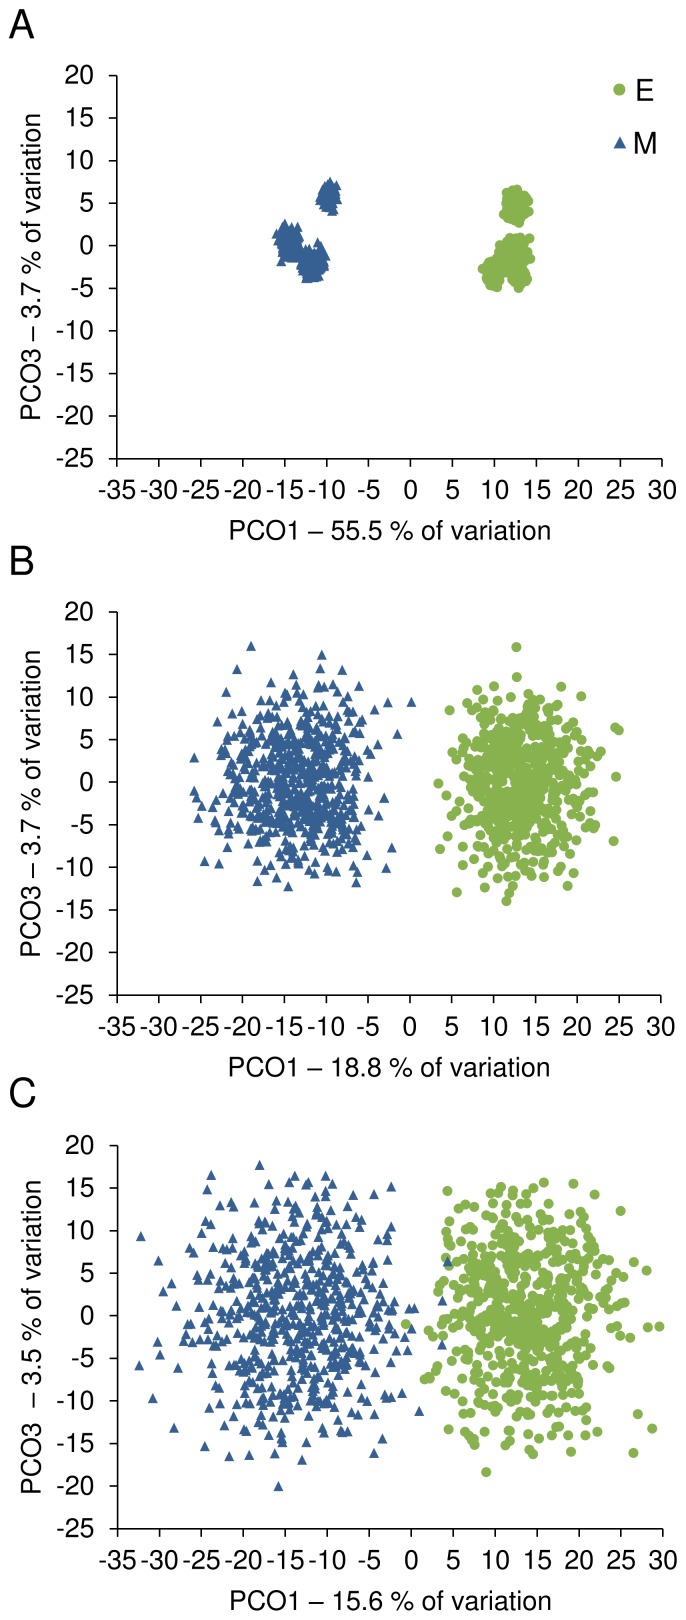
PCoA plot for the salivary bacterial communities assessed by 16S rDNA pyrosequencing.A Perl script was used for random picking of 4000 (A), 100 (B), and 50 (C) OTUs from each sample of the normalized dataset in Pipeline 6. Sub-sampling was performed 100 times and the relative abundance of OTUs obtained in each iteration was square root-transformed and used to construct the Bray-Curtis similarity matrix, which was then used in the PCoA. E, enzymatic lysis; M, mechanical lysis.